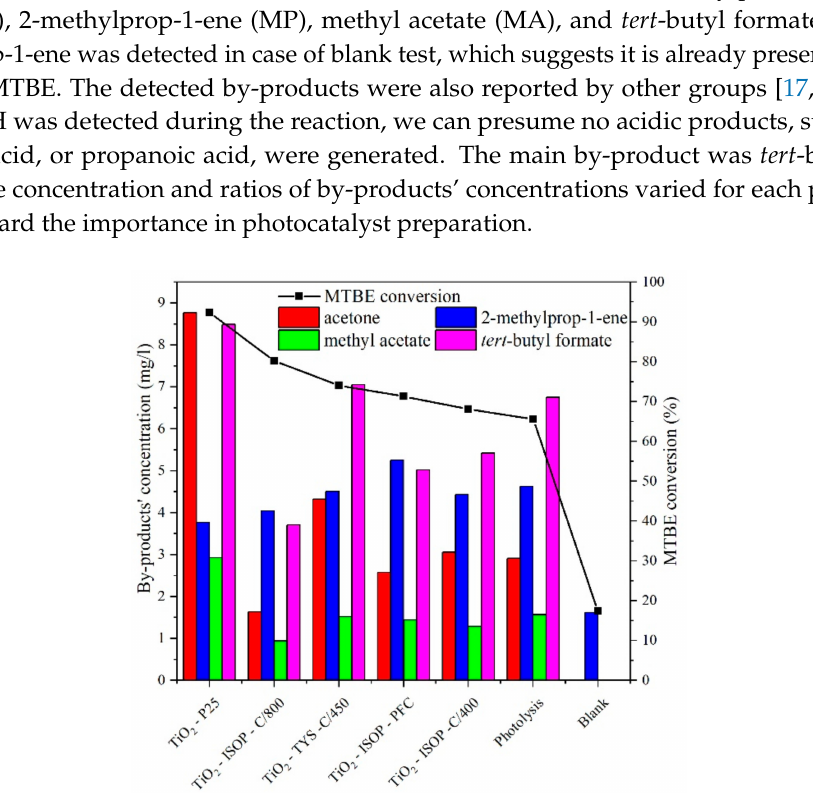
Figure 6. Correlation between by-products’ concentrations and MTBE conversion for each photocatalyst, photolysis, and blank measurement after 60 min of irradiation (254